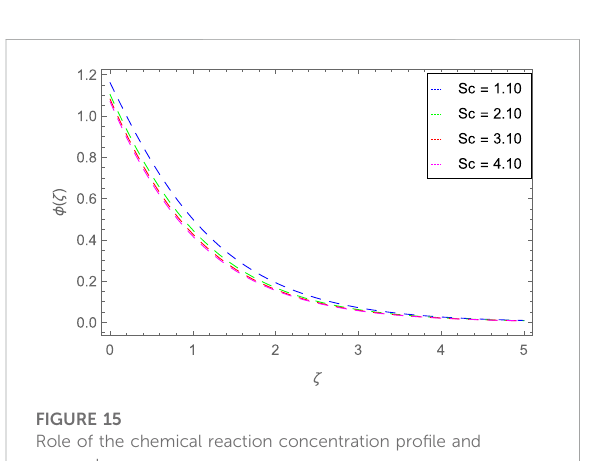
FIGURE 15 Role of the chemical reaction concentration pro fi le and